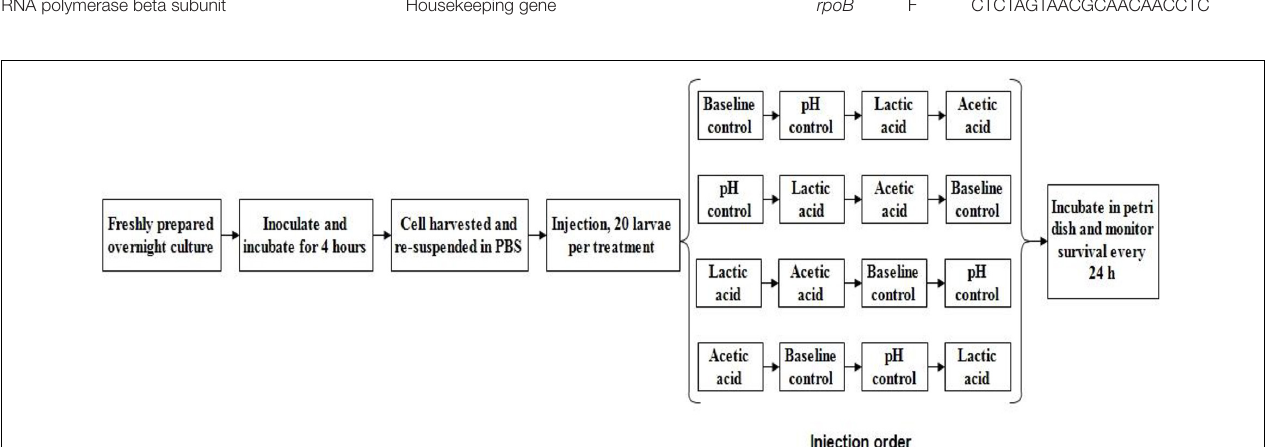
FIGURE 1 | Galleria mellonella schematic experimental design of one biological repetition.